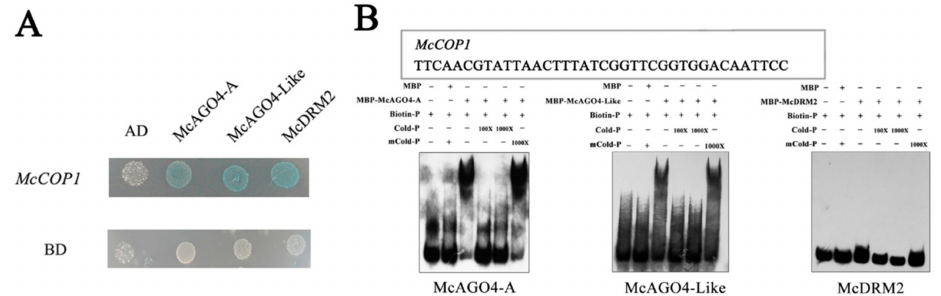
Figure 4. McAGO4 proteins bind to the McCOP1 promoter. ( A ). Yeast one-hybrid assays indicated that McAGO4-A, McAGO4-Like and McDRM2 bind directly to the McCOP1 promoter. ( B ). Interaction status of the McAGO4-A, McAGO4-Like, McDRM2 proteins and the McCOP1 promoter determined by electrophoretic mobility shift